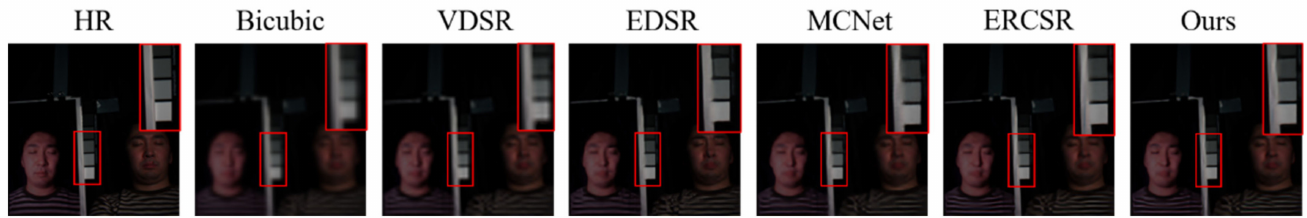
Figure 6. The reconstructed images and detailed comparison images of the photo_and_face_ms using various algorithms. Reconstructed images with spectral bands 26-17-9 as R-G-B channel with a scale factor of